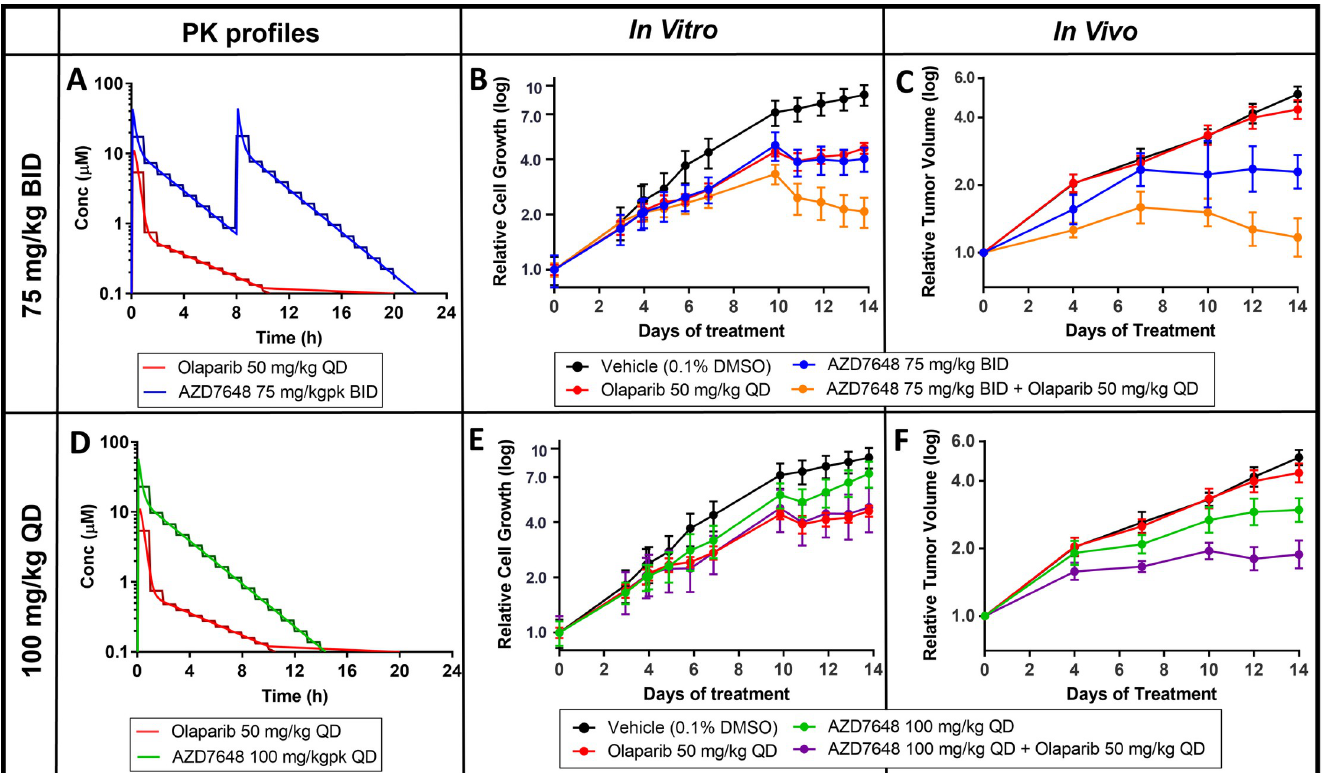
Fig 4. Olaparib and DNA-PK inhibitor AZD7648 in vivo PK profiles replicated using the Microformulator: comparing antiproliferative effect in vitro with in vivo results. (A) In vivo PK profiles of olaparib (50 mg/kg QD) and AZD7648 (75 mg/kg BID) (continuous line, red and blue) matched with Microformulator-generated PK profiles (stepped line, red and blue). (B) IncuCyte analyisis of FADU ATM KO cell growth inhibition effects of olaparib and AZD7648 (75 mg/kg BID) monotherapy or combination delivered by the Microformulator each day for 14 days. (C) TGI of FaDu ATM KO xenografts treated with olaparib and AZD7648 (75 mg/kg BID) as monotherapy and in combination (SCID mice, n = 4–9 day 14). Data represent geomean ± SEM (tumour start volume 0.26 cm 3 ). (D) In vivo PK profiles of olaparib (50 mg/kg QD) and AZD7648 (100 mg/kg QD) (continuous line, red and green) matched with Microformulator-generated PK profiles (stepped line, red and green). (E) IncuCyte analyisis of FADU ATM KO cell growth inhibition effects of olaparib and AZD7648 (100 mg/kg QD) monotherapy or combination delivered by the Microformulator each day for 14 days. (F) TGI of FaDu ATM KO xenografts treated with olaparib and AZD7648 (100 mg/kg QD) as monotherapy and in combination (SCID mice, n = 8–9 day 14). Data represent geomean ± SEM (tumour start volume 0.26 cm 3 ). Underlying data can be found in S2 Data. DNA-PK, DNA-dependent protein kinase; KO, knockout; PK, pharmacokinetic; TGI, tumour growth